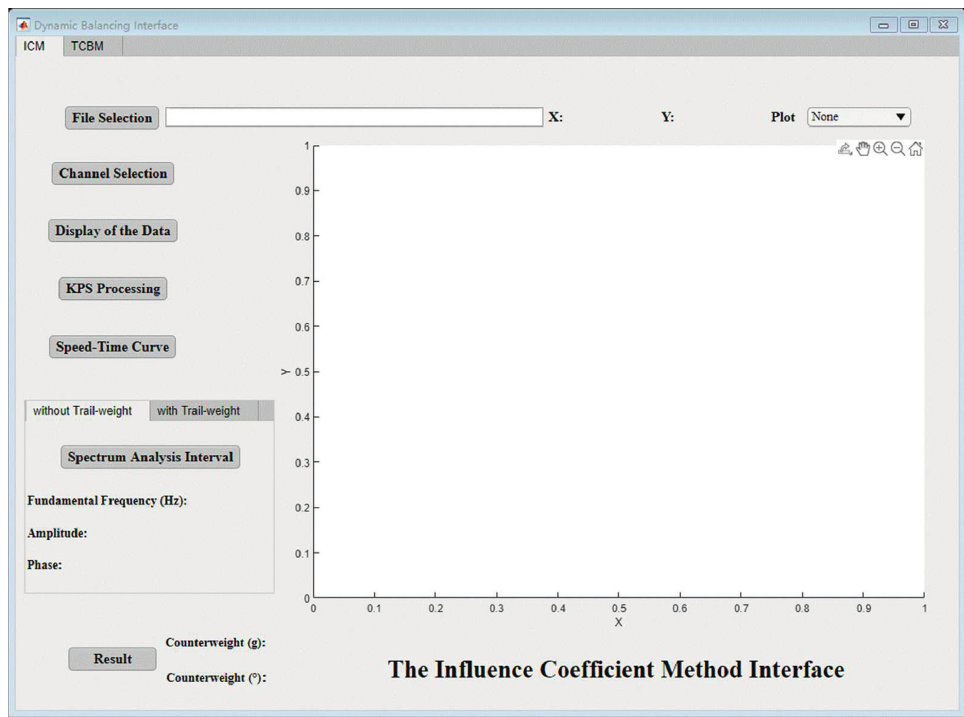
Figure 11: The influence coefficient method interface.